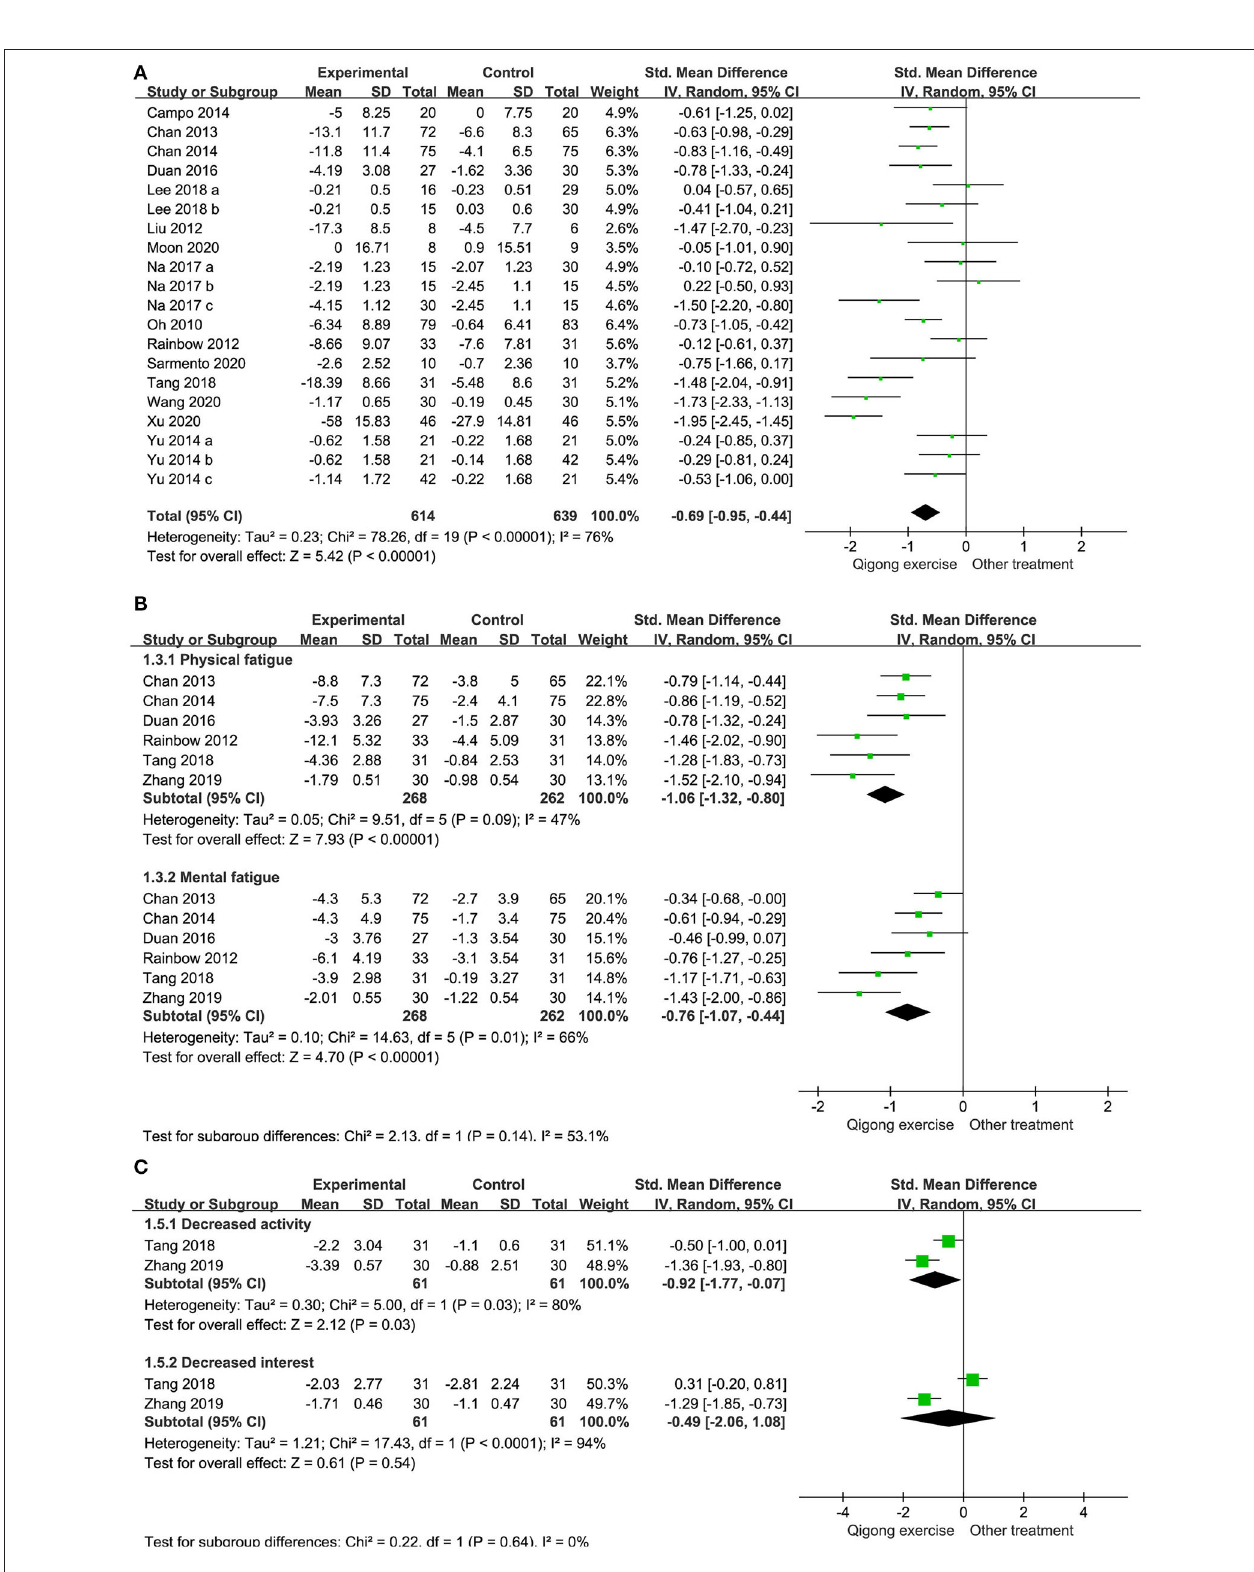
FIGURE 3 | Forest plots illustrating the meta-analysis of outcomes with Qigong exercise (QE) vs. other treatments for fatigue symptoms. The outcomes analyzed were (A) total fatigue intensity, (B) physical and mental fatigue intensity, and (C) decreased activity and interest scale.